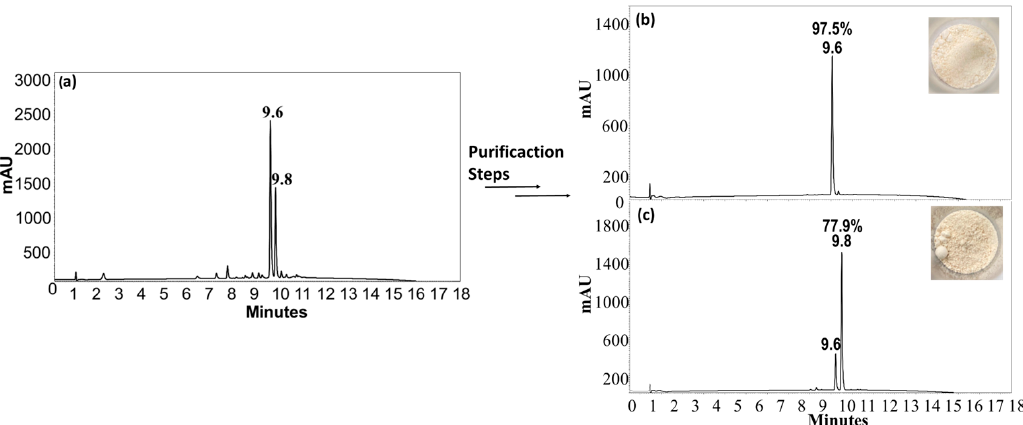
Figure 2. Chromatographic profile of crude reaction product ( a ) obtained in the synthesis of C -Tetra(4-(prop-2-yn-1-yloxy)phenyl)calix[4]resorcinarene. ( b , c ) show the profiles obtained for purified products.